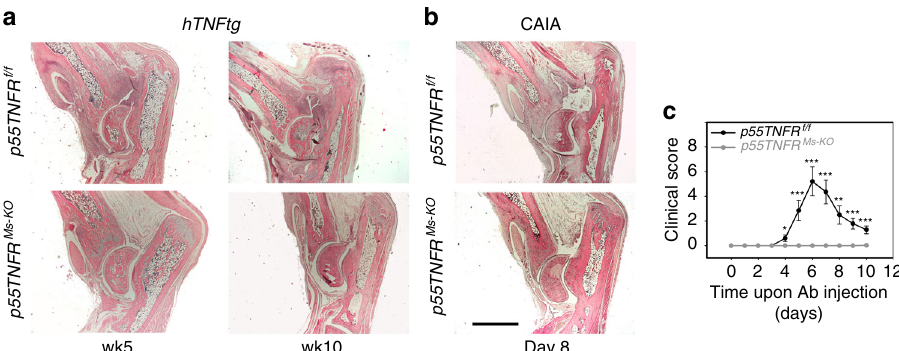
Fig. 1 Mesenchymal p55TNFR signals are necessary for the development of TNF-mediated arthritis. a Representative histological images of haematoxylin & eosin (H&E)-stained ankle joint sections of hTNFtg p55TNFR f/f ( n = 5, age: week 5; n = 8, age: week 10) and hTNFtg p55TNFR Ms-KO mice ( n = 8, age: weeks 5 and 10). b Representative histological images of H&E-stained ankle joint sections of p55TNFR f/f and p55TNFR Ms-KO mice subjected to CAIA at the peak of disease (Day 8). c Representative scoring of clinical manifestations of p55TNFR f/f ( n = 7) and p55TNFR Ms-KO mice ( n = 8) subjected to CAIA (total 3 experiments, n = 20 mice per genotype). Arthritis was induced in male mice by i.v. injection of 4 mg collagen II antibody cocktail (Ab) on Day 0 followed by 75 μ g LPS i.p. 3 days later. Scale bar: 1 mm. Data are presented as the mean ± SEM. * P < 0.05, ** P < 0.01 and *** P < 0.001 by two-tailed Student ’ s t